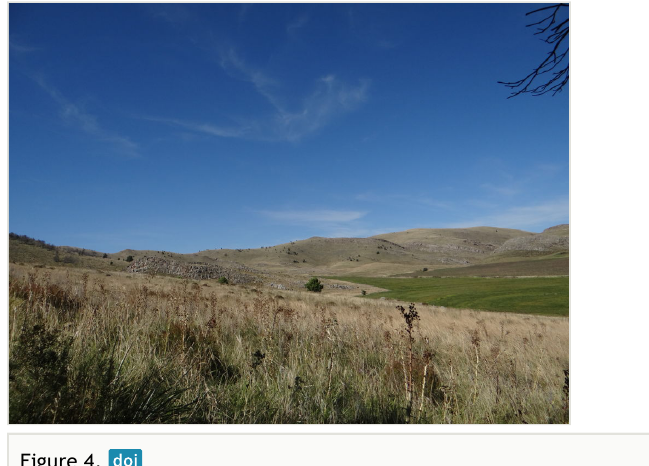
Figure 4. Habitat of C. simoni in